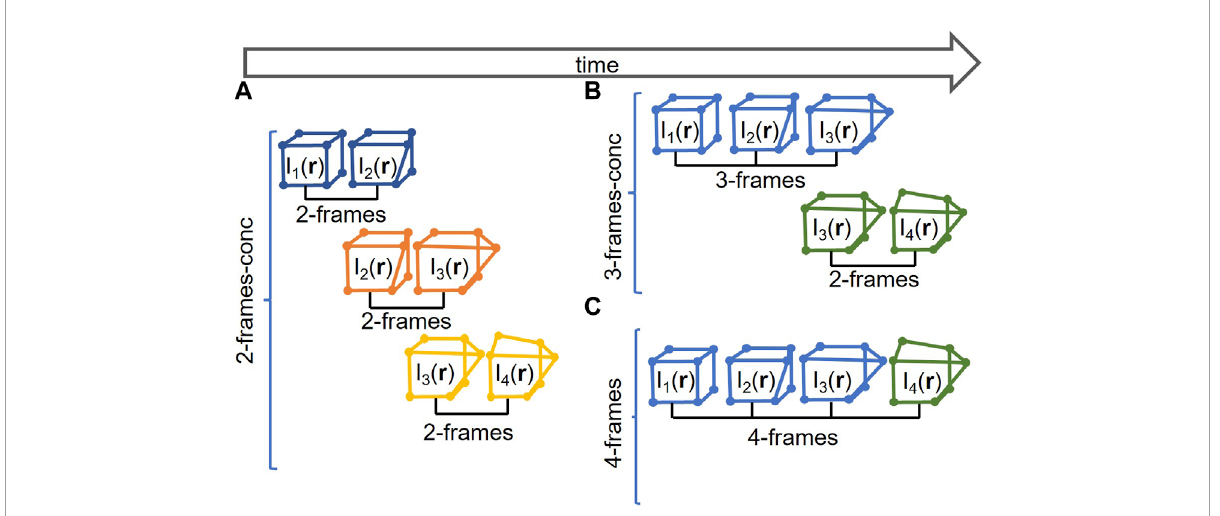
FIGURE 3 (A) Schematic explanation of concatenation of the 2-frames method (2-frames-conc); (B) schematic explanation of concatenation of the 3-frames and 2-frames method (3-frames-conc); (C) schematic explanation of the 4-frames